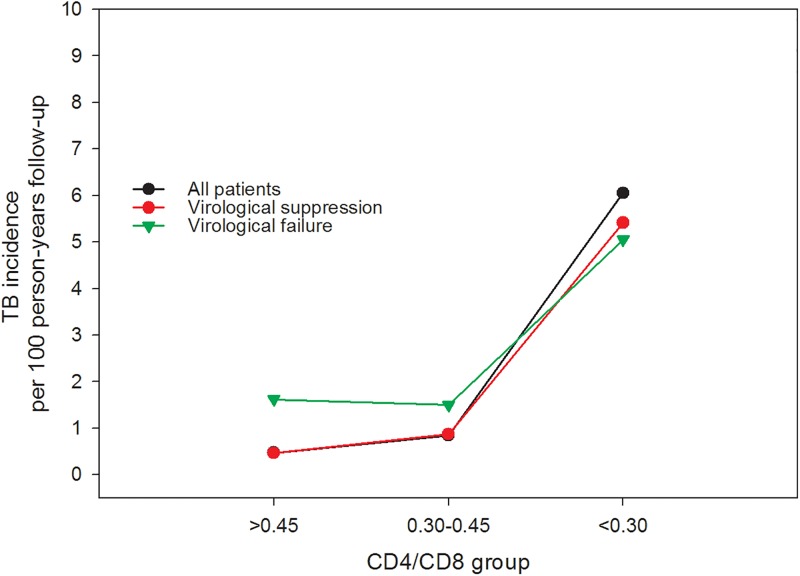
The incidence rate of tuberculosis (TB) in the different CD4/CD8 ratio group.